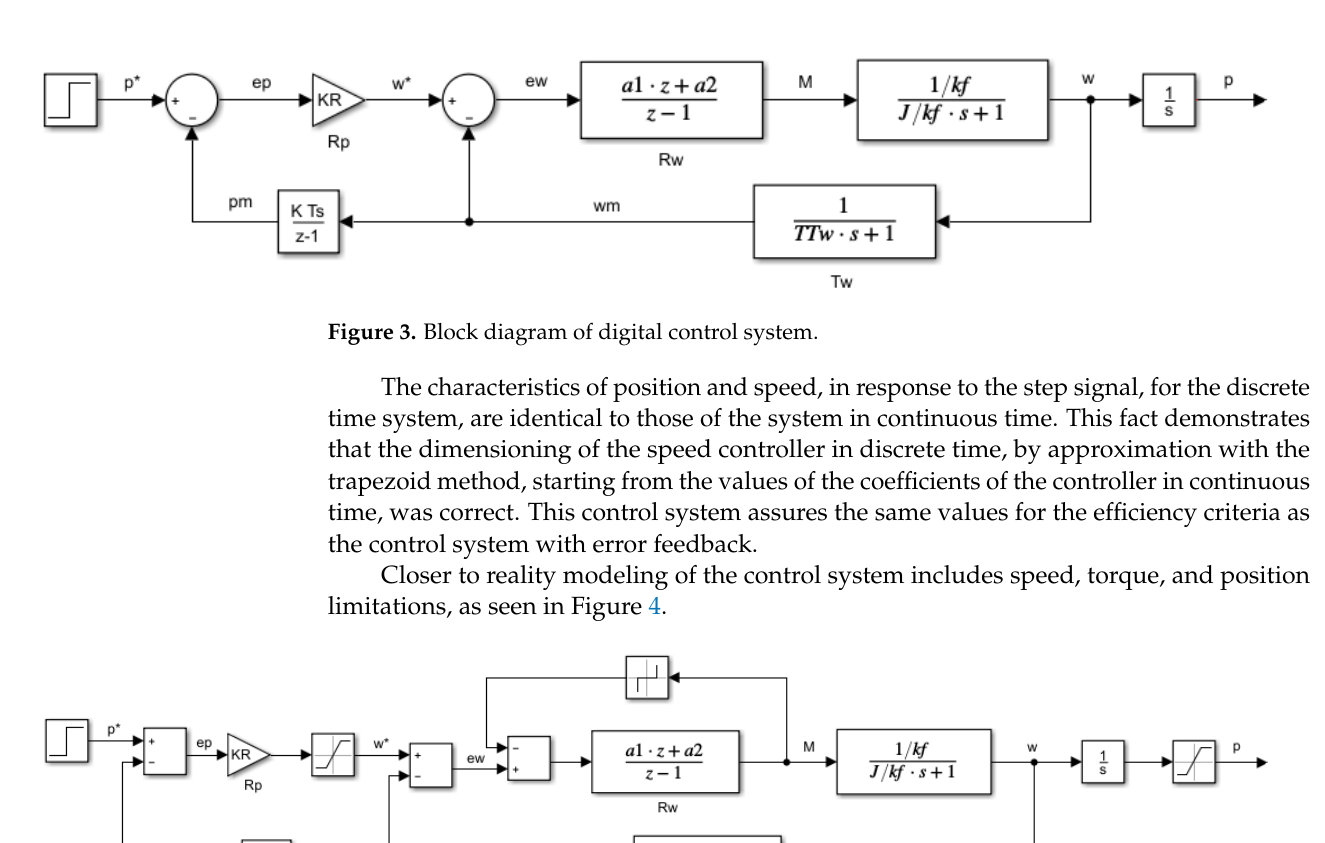
Figure 5. Block diagram of state feedback control system. The state equations of systems are: